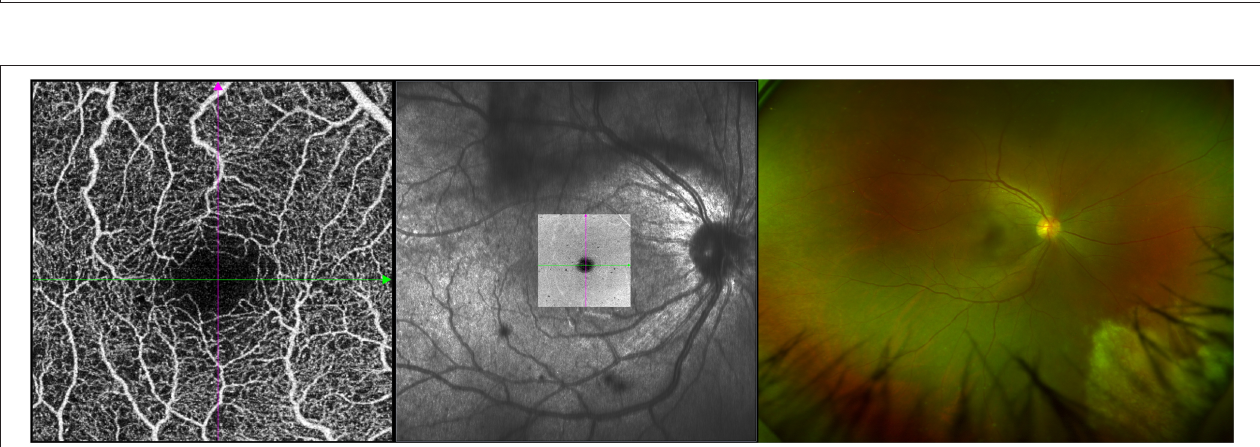
FIGURE 2 | An example of active CMVR in the right eye showing vitreous opacity in the OCTA image (left), en face image (middle), and ultrawide-field (UWF) fundus photograph (right).